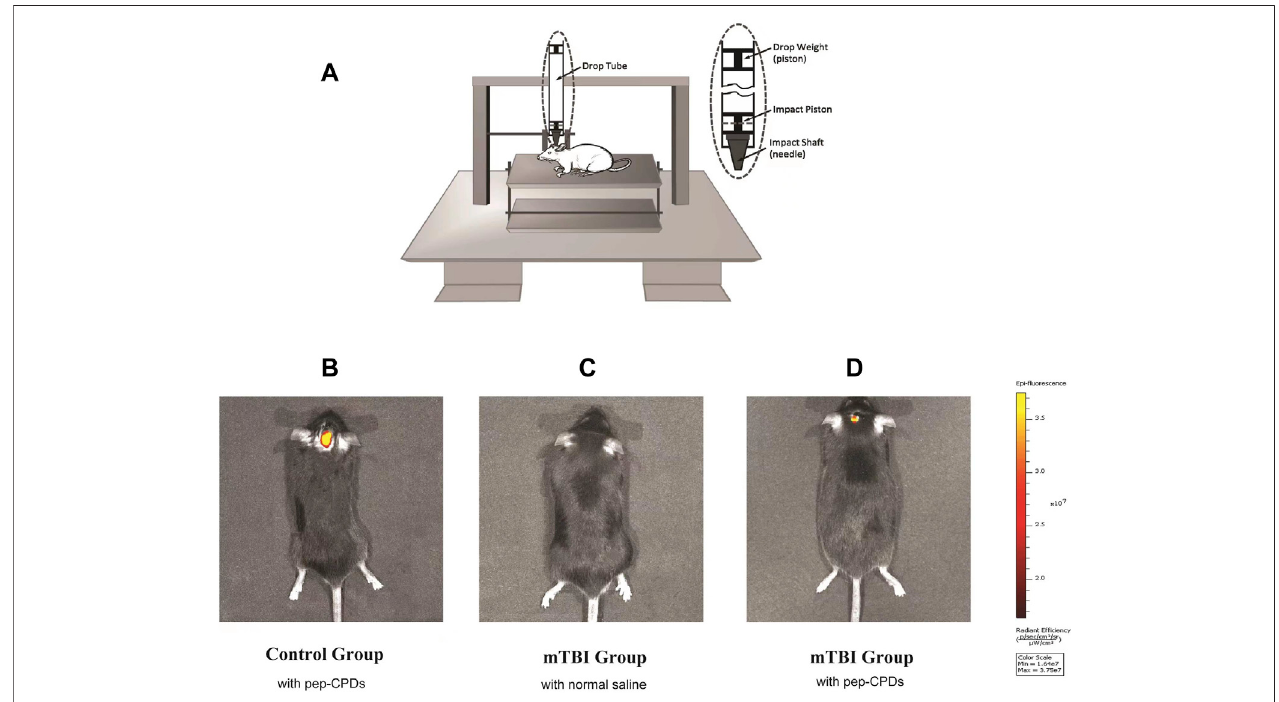
FIGURE 4 | (A) . Modeling of mTBI using an improved weight-drop impactor. Fluorescence imaging of control group mouse (B) and mTBI group mouse (C,D) . In vivo fl uorescence of the nanoprobe when injected via mouse inner canthus